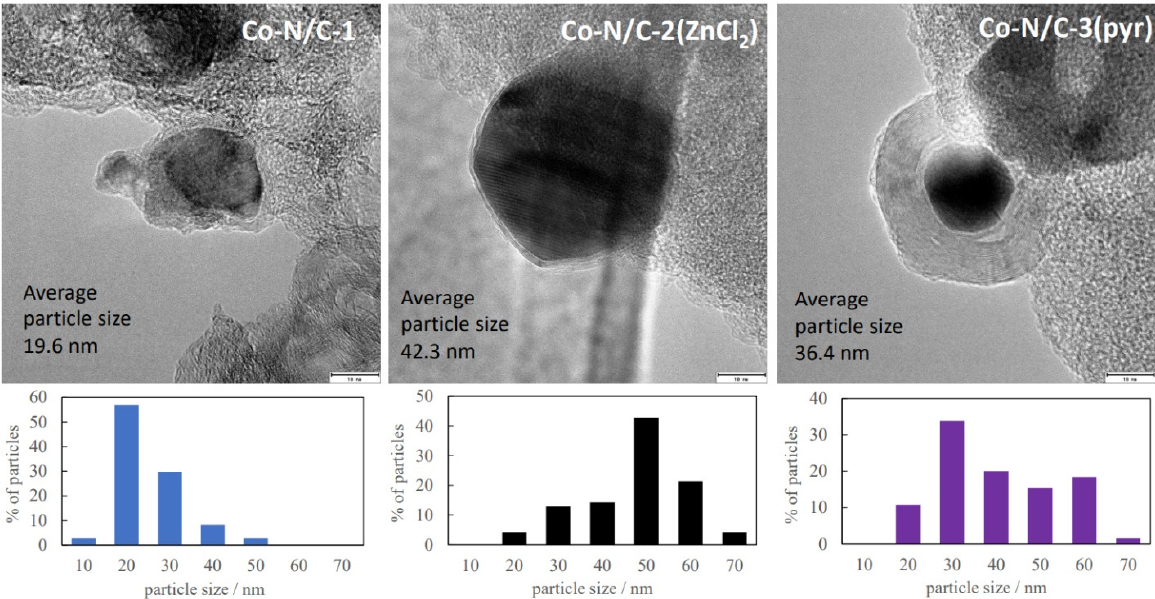
Figure 4. HR-TEM images and particle size distribution for three catalyst materials (noted in Figure).